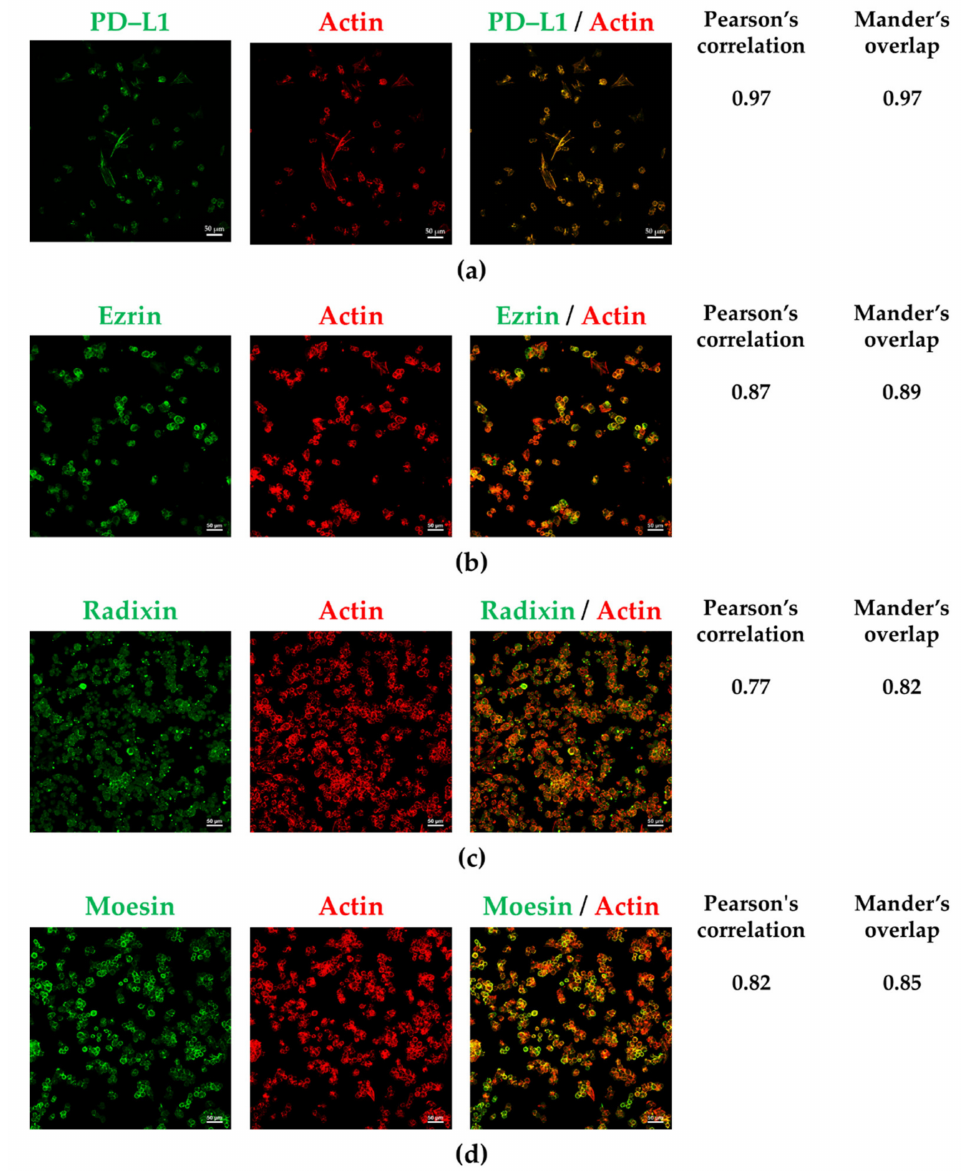
Figure 2. Subcellular localization of programmed death ligand–1, ezrin, radixin, and moesin in A2780 cells. Left panels: Alexa Fluor 488 (green)-labeled ( a ) programmed death ligand–1 (PD–L1), ( b ) ezrin, ( c ) radixin, and ( d ) moesin; middle panels: tetramethylrhodamine (red)-labeled F-actin; right panels: merged fluorescence images. Scale bars: 50 µ m. The coefficients of Pearson’s correlation and Mander’s overlap to quantify the colocalization of each protein with actin shown on the right side of each image were expressed as the mean of five independent